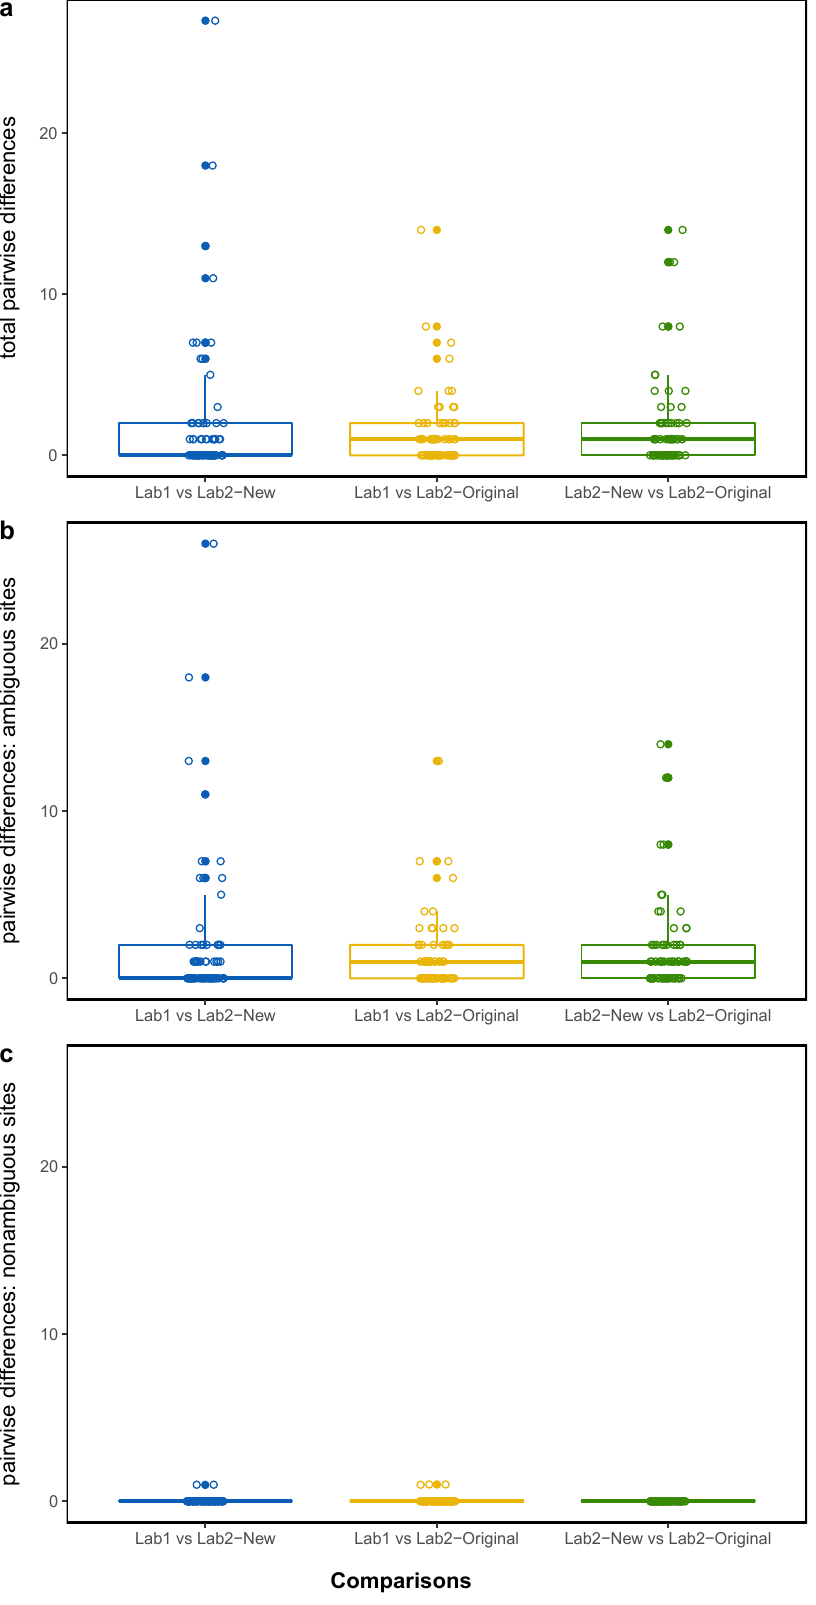
Figure 2. Boxplots depicting the number of differences between matched SARS-CoV-2 genome sequences across 216 pairwise comparisons. ( a ) total number of differences; ( b ) number of